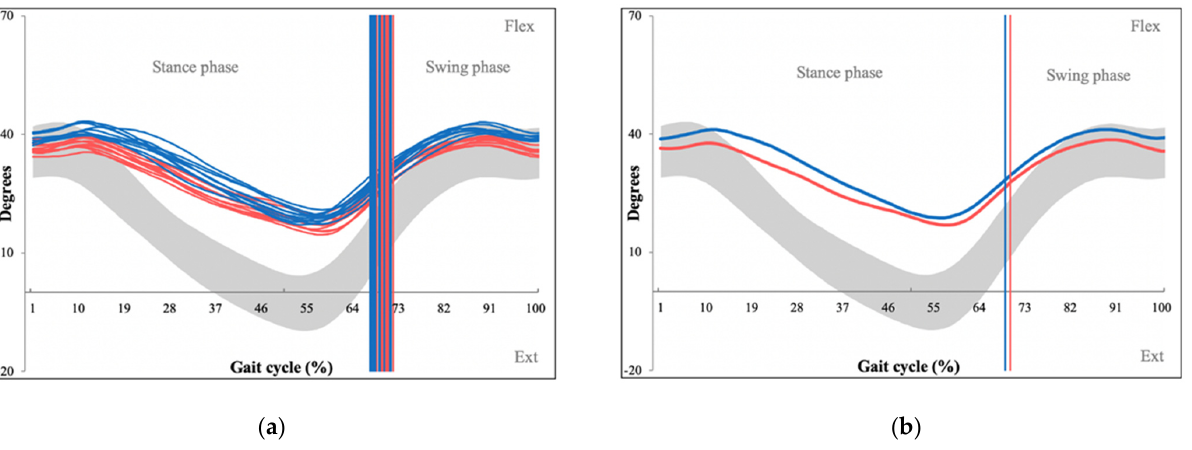
Figure 4. Kinematic consistency motion graphs of hip flexion/extension during 15 gait cycles ( a ) used to generate an average kinematic motion graph ( b ), which then generates the patient’s Gait Variable Score (GVS) for hip flexion/extension. Degrees of movement are shown on the vertical axis whereas the horizontal axis portrays the gait cycle. (Red line—left leg values, blue line—right leg values, grey space—normative values for hip flexion/extension.)